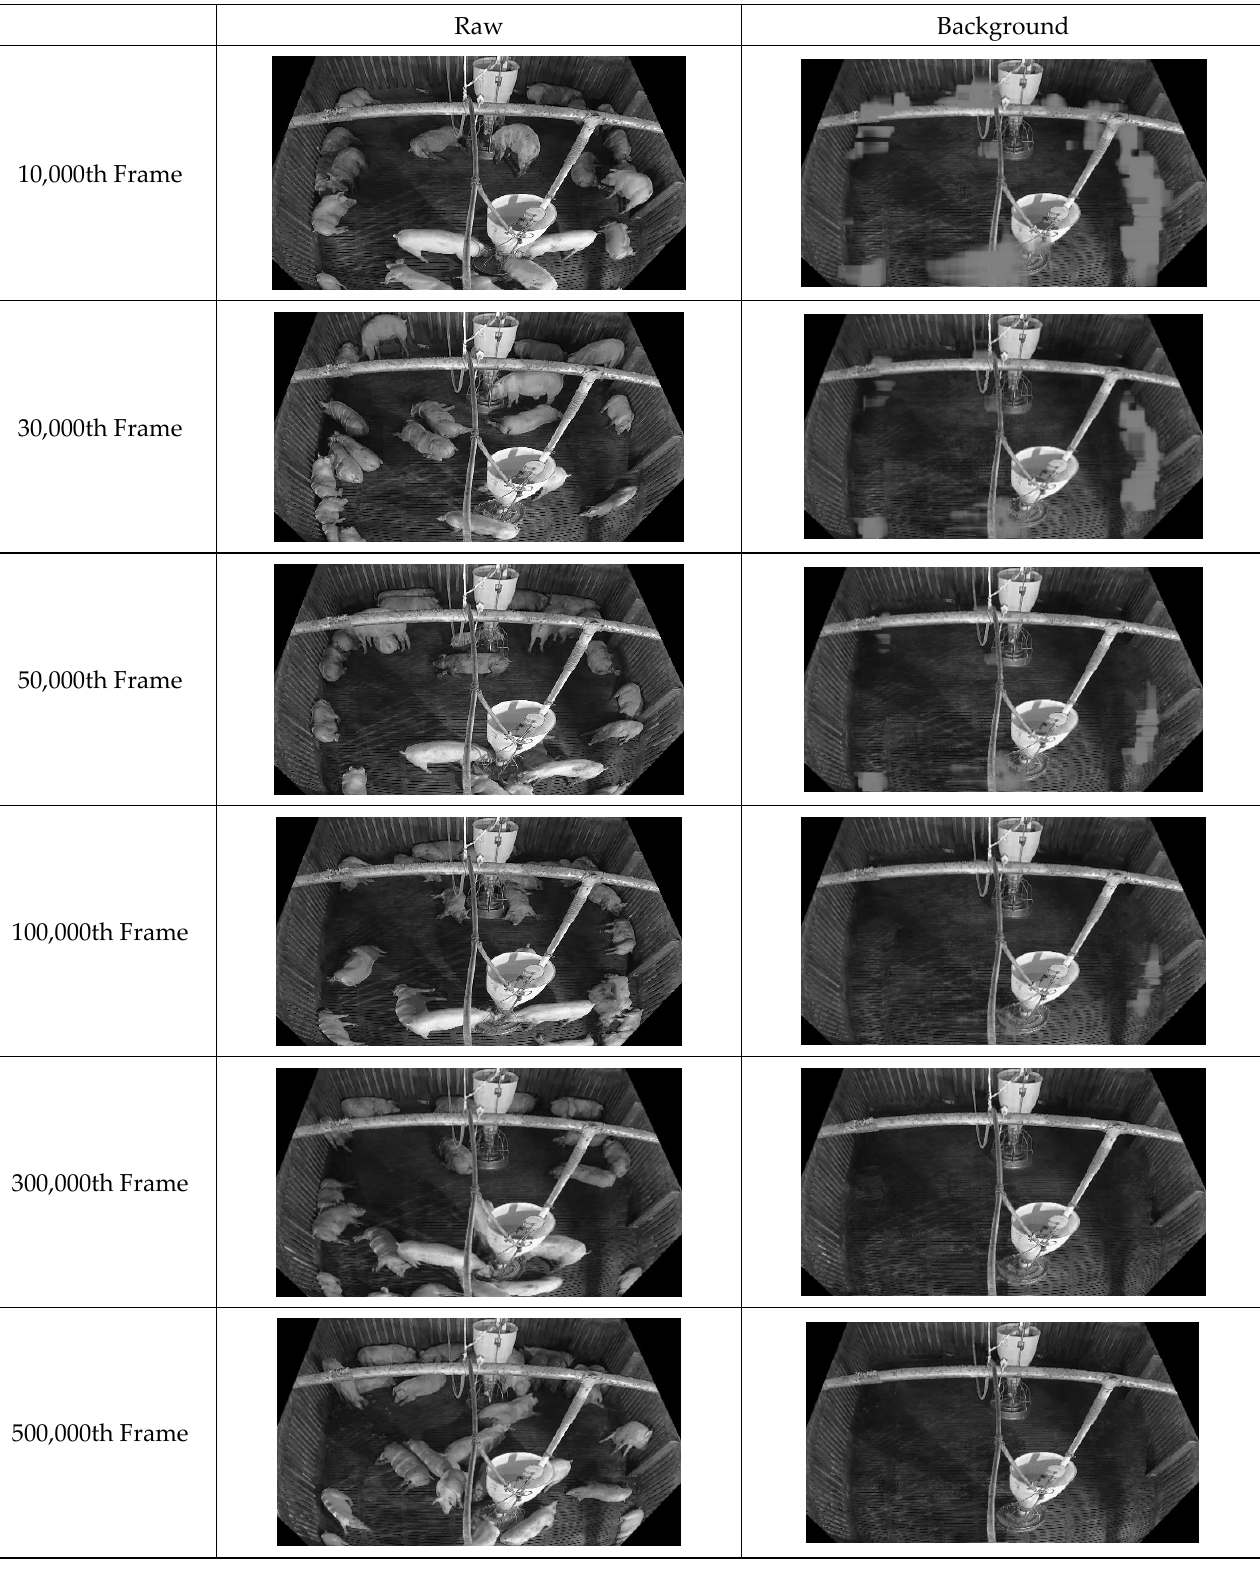
Figure 10. Illustration of Background Image Generation of 500,000 frames with showing each consecutive 20,000 frames, 200,000 frames.